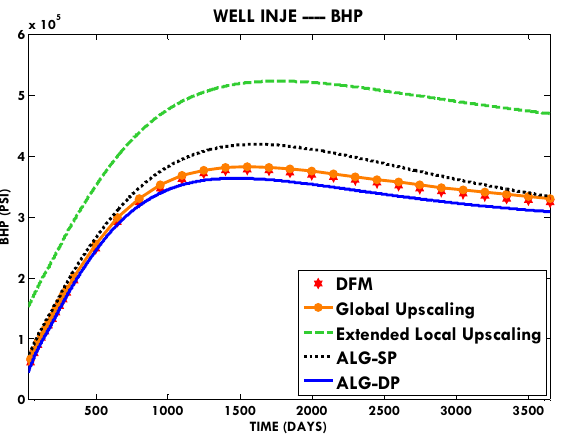
Figure 11. BHP of injection well for case 2.